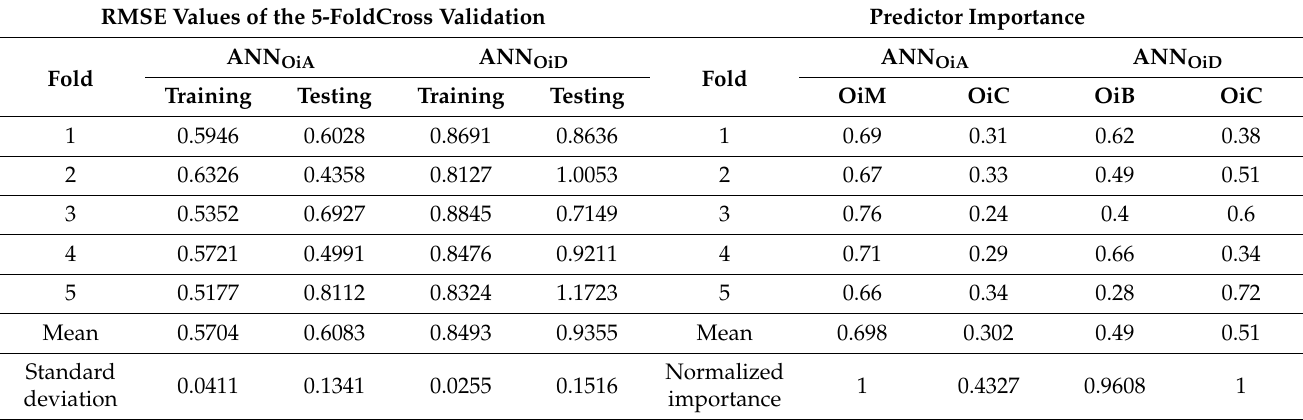
Table 10. The five-fold cross-validation and predictor importance